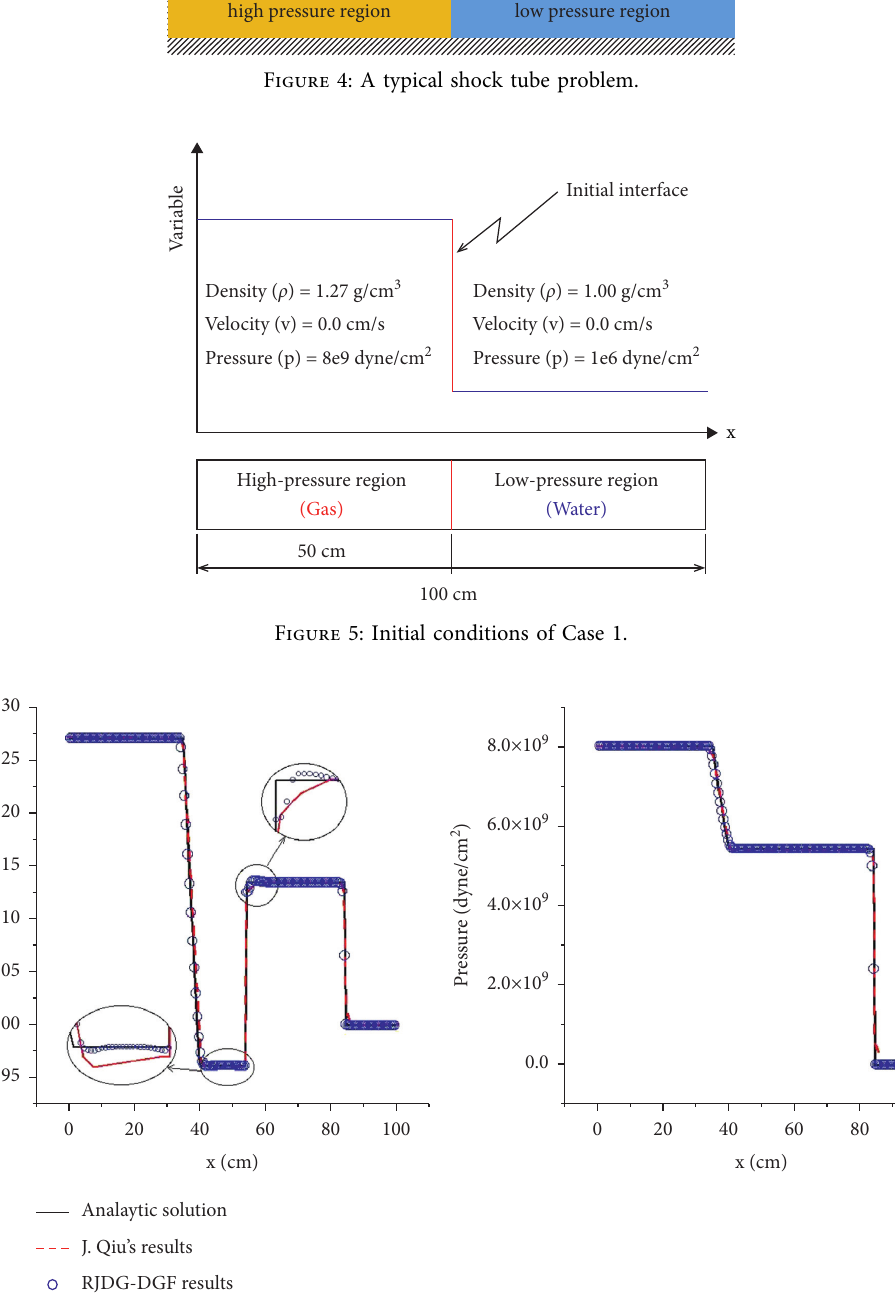
Figure 6: RKDG-DGFM results of Case 1 at 0 . 16 × 10 − 3 seconds.